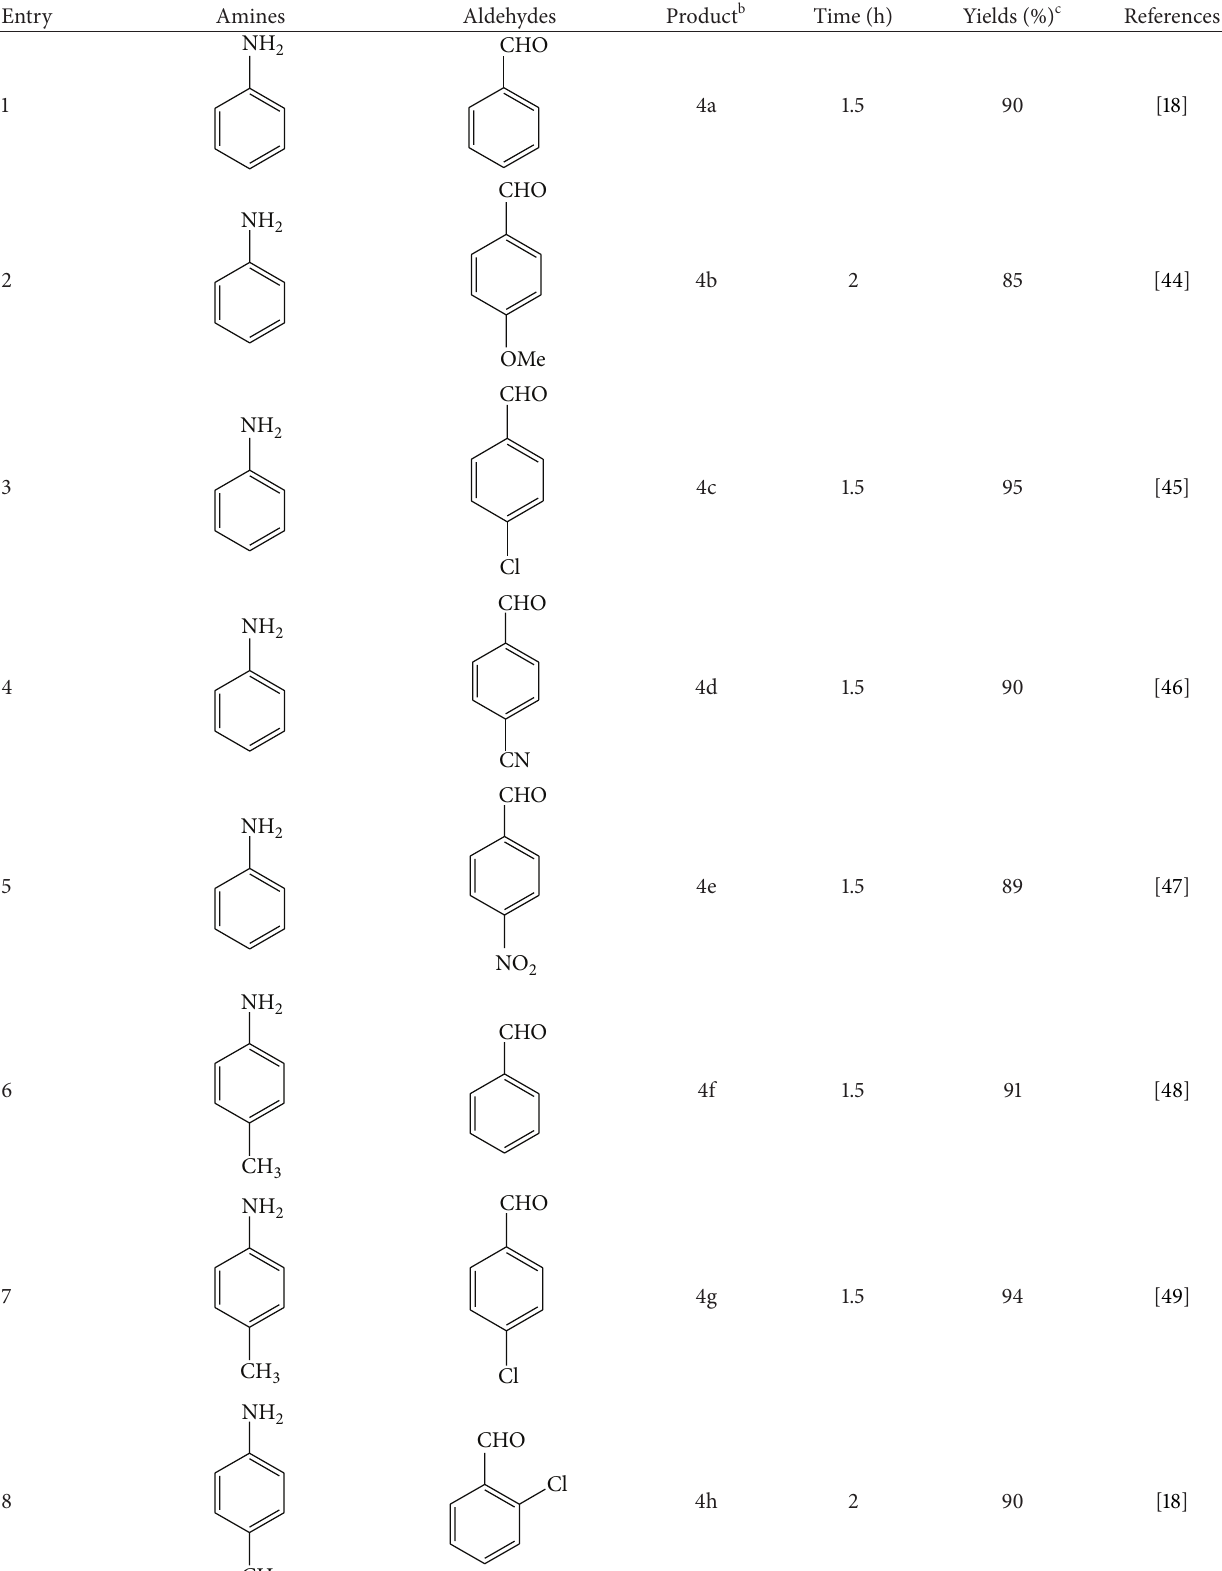
Table 3: Synthesis of N -substituted decahydroacridine-1,8-diones using Cu-doped ZnO nanocrystalline powder (10mol%) as a catalyst in solvent-free condition a